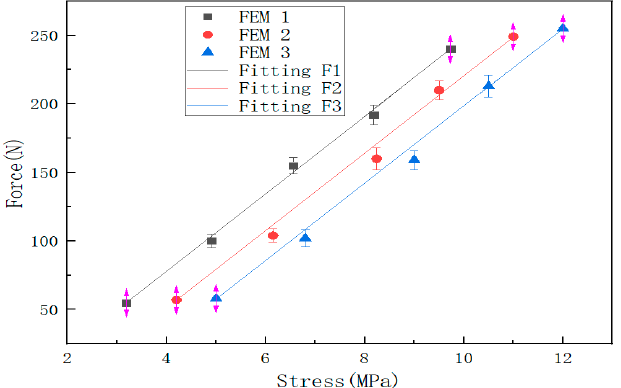
Figure 15. The relationship between impact force and stress response at three impact points. Table 2. The functional relationship of finite element analysis shock model. Finite Element Analysis